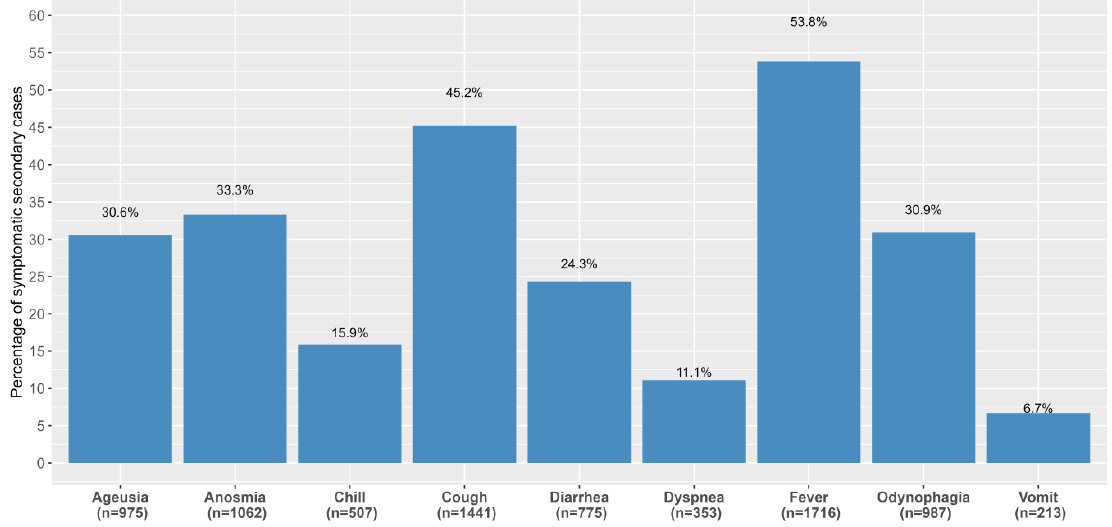
Figure 3. Typology of COVID-19-like symptoms developed among secondary cases (SCs). Note: SCs could report one or more symptoms; percentages are calculated from an overall 3190 sample of SCs.